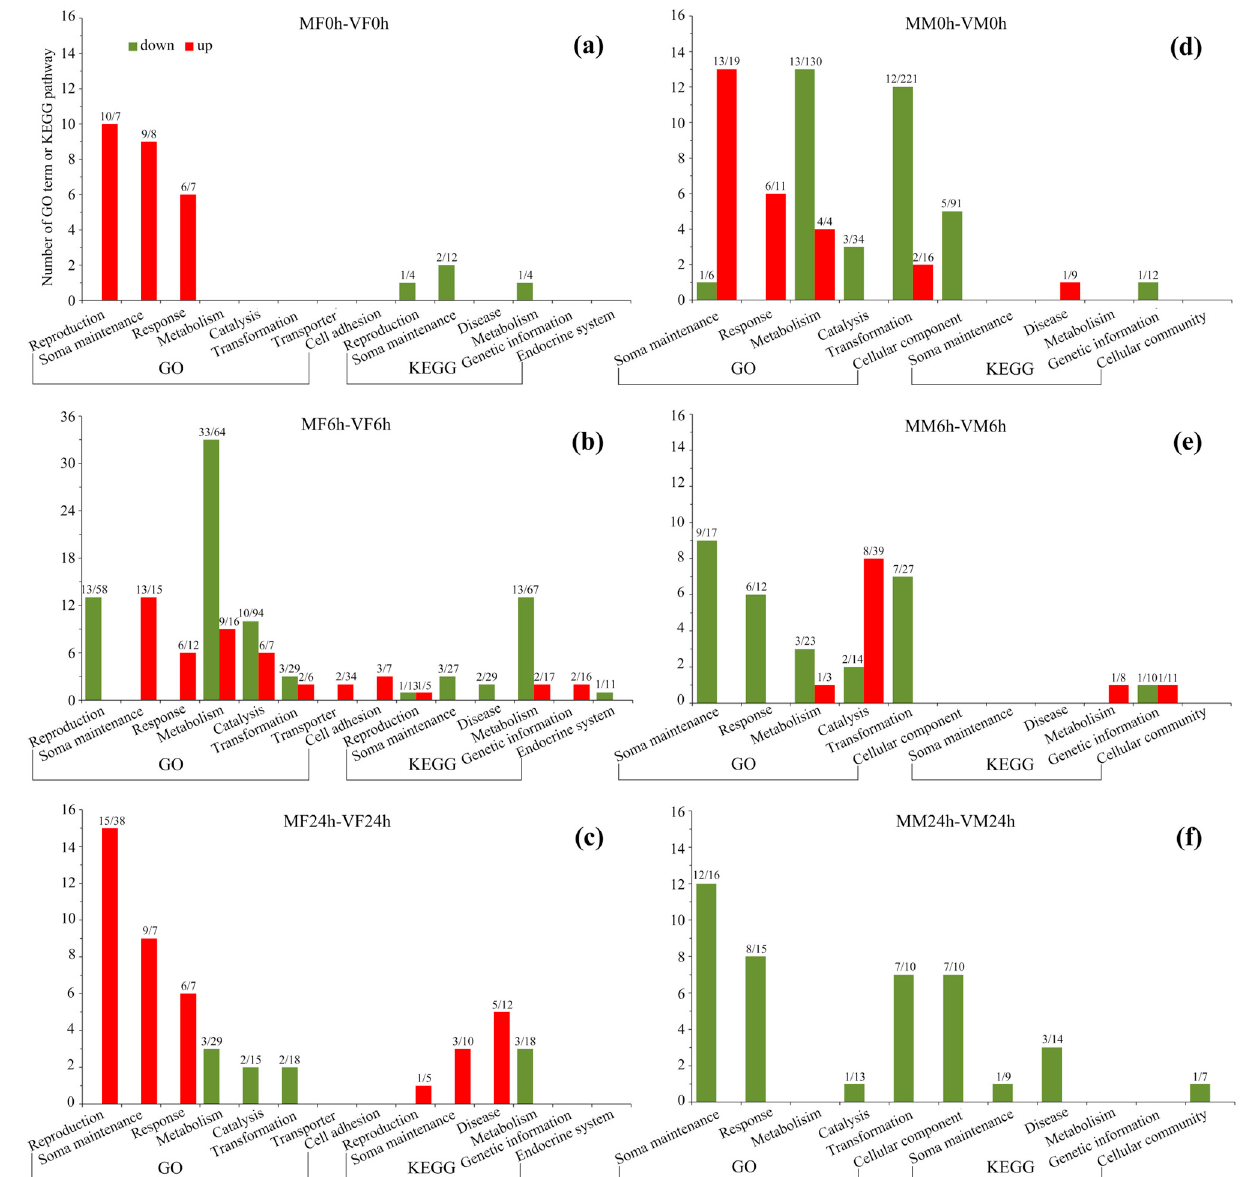
Figure 5. Enriched GO terms and KEGG pathways in S. frugiperda . ( a – c ) represent terms and pathways in females at 0, 6 and 24 h postmating, respectively; ( d – f ) represent terms and pathways in males at 0, 6 and 24 h postmating, respectively. Red columns represent terms/pathways enriched to upregulated DEGs and green columns represent terms/pathways enriched to downregulated DEGs. At the top of columns, the first number represents the number of terms/pathways and the second number represents the number of enriched DEGs.